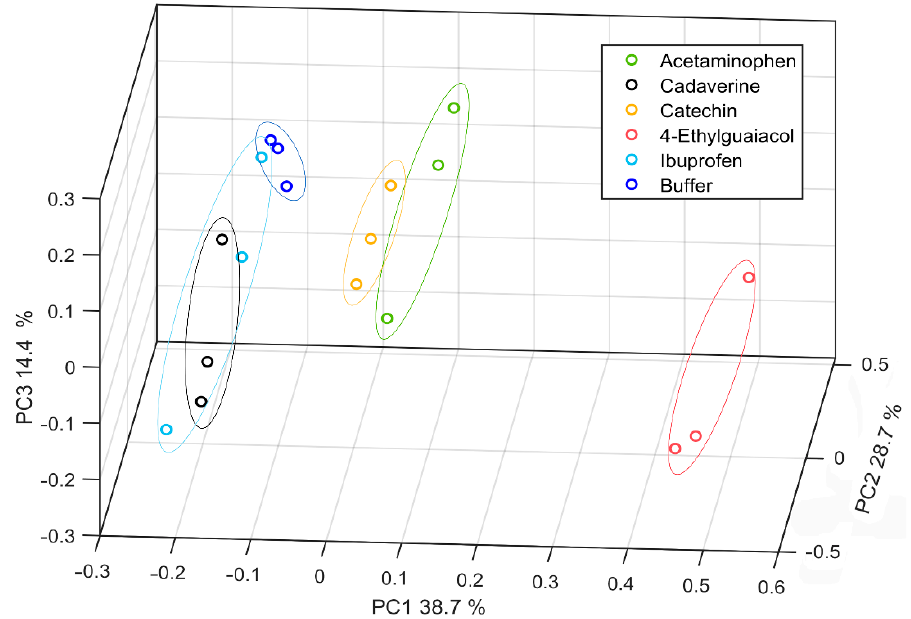
Figure 9. PCA Score plot for the three principal components of 6 different molecules, acetaminophen, cadaverine, catechin, 4-Ethylguaiacol, and ibuprofen.